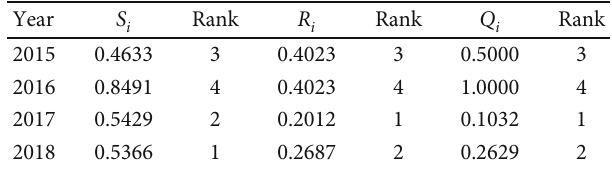
R Q i , i , and i value of the resource consumption